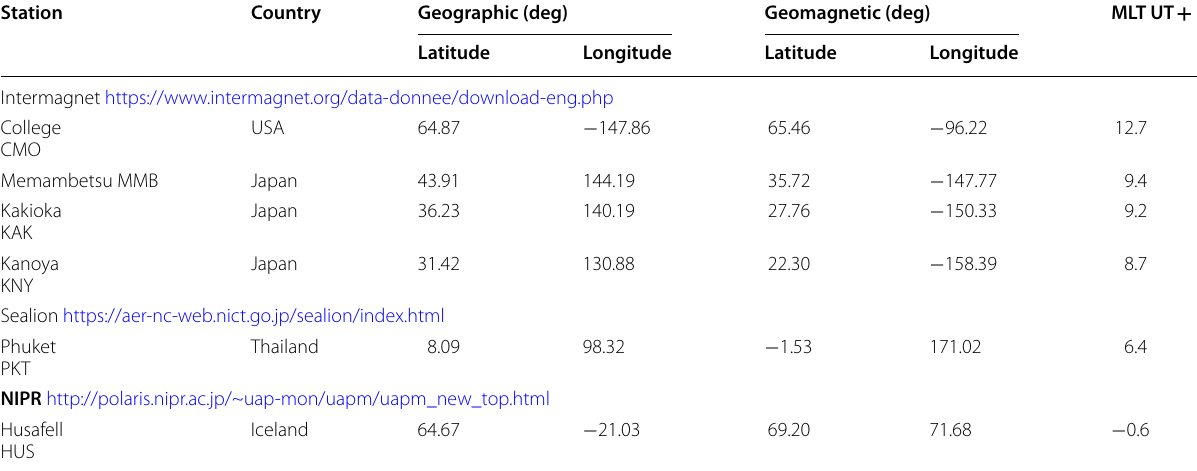
Table 2 List of the INTERMAGNET, SEALION, and NIPR Magnetometers Station Country Geographic (deg)